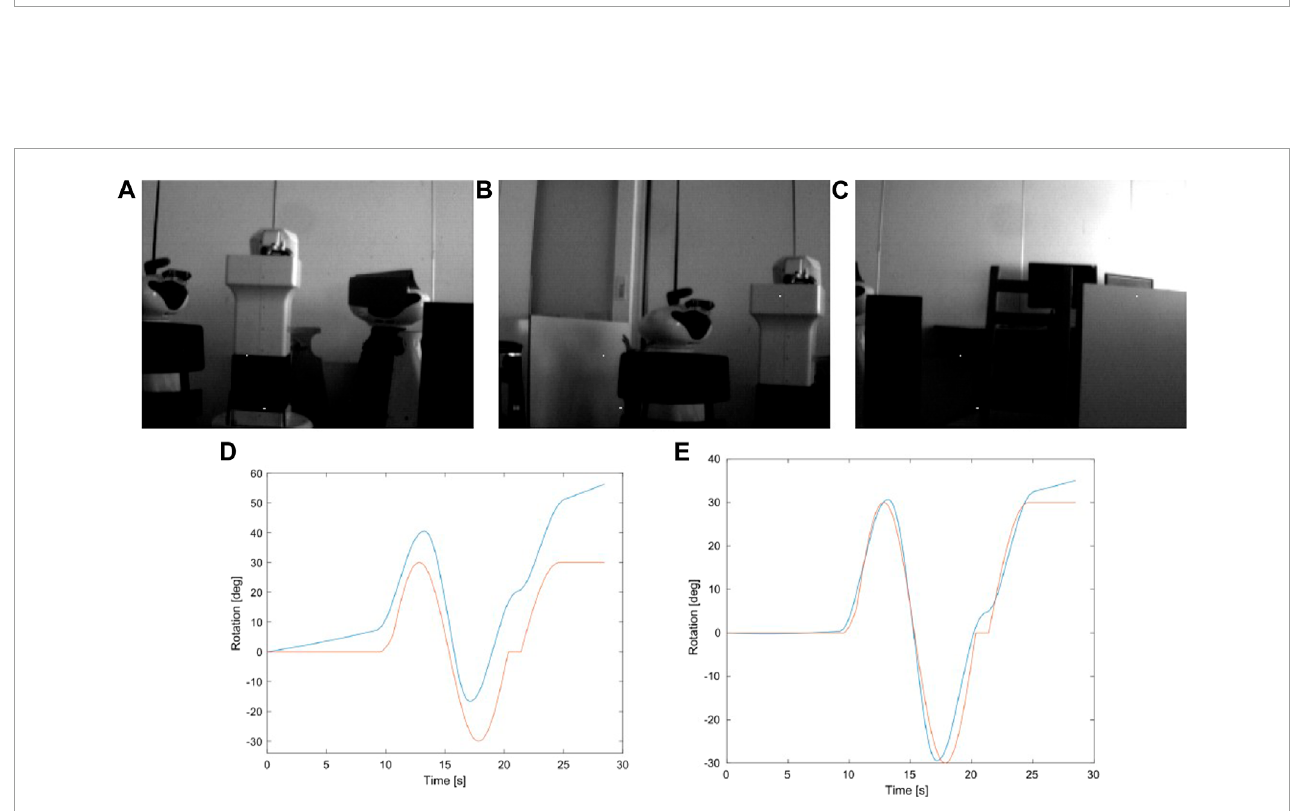
FIGURE 8 (A–C) show samples from the scene recorded for the experimnent using the Kinova robot arm. (D) and (E) compare the groundtruth (orange) with the estimation (blue) from the case where no prior is given (D) and when some information from the biases is used for initialization (E)